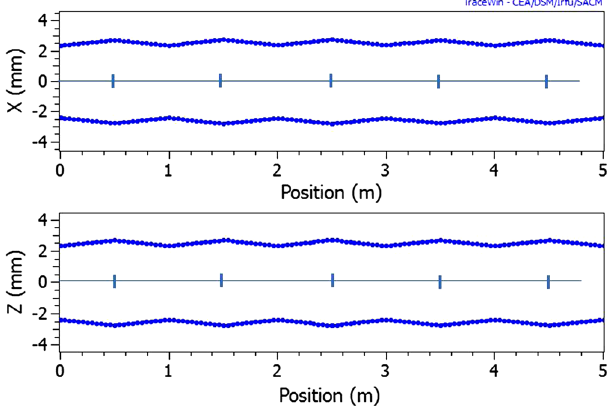
FIG. 1. Envelope of spherical bunch in standard periodic solenoid lattice with bars indicating positions of combined solenoid and rf kicks (5 periodic